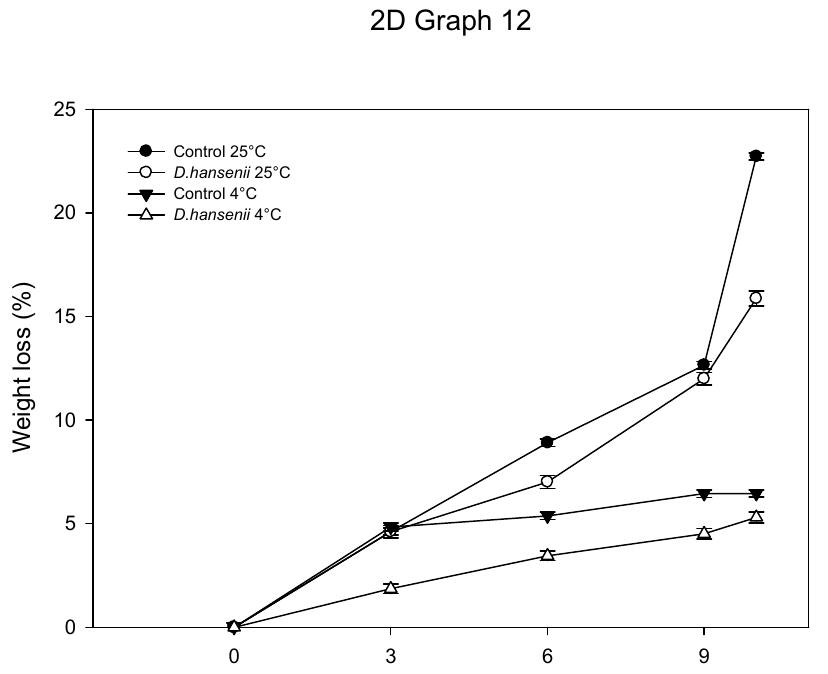
Figure 7. Physiological weight loss in blueberry fruits stored at 25 °C and 4 °C under the application of D. hansenii . Values are expressed as mean ± standard error.